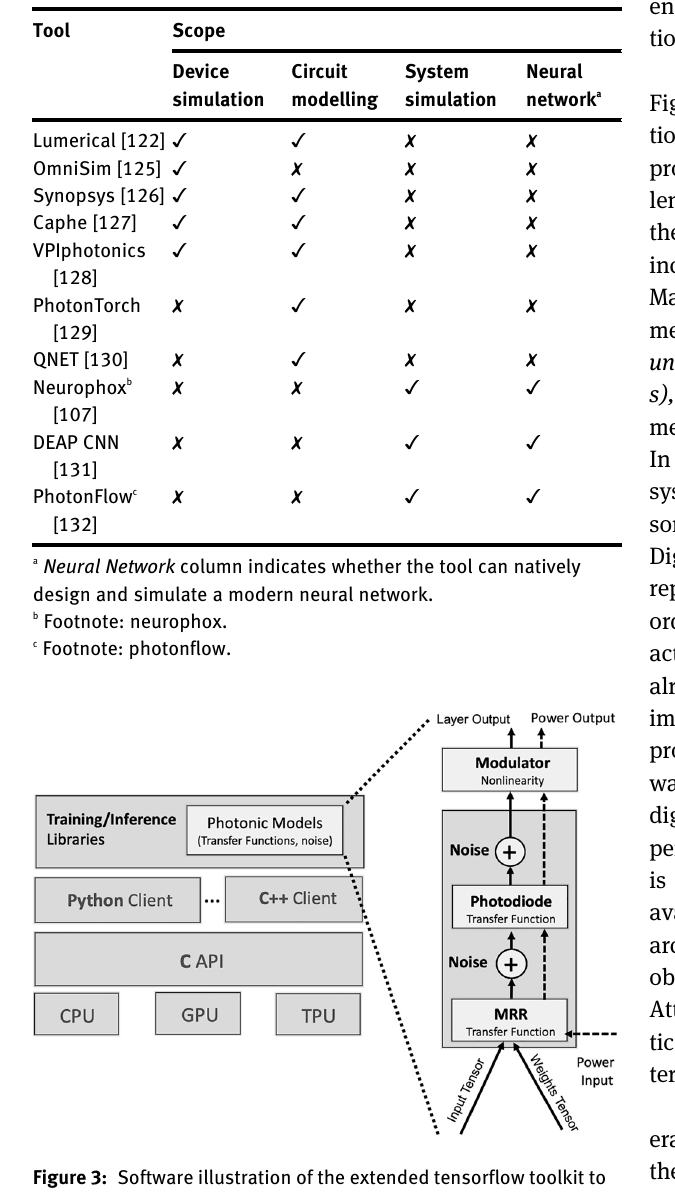
Figure 3: Software illustration of the extended tensorflow toolkit to handle WDM-based photonic systems.